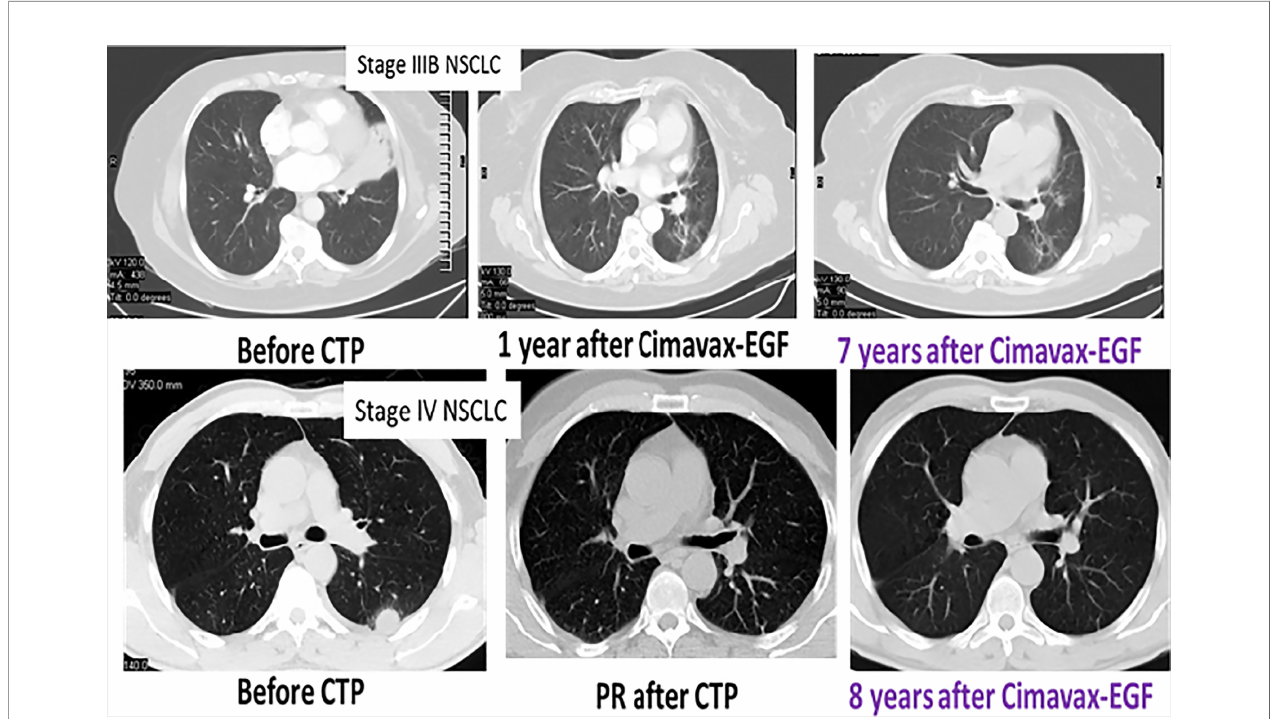
FIGURE 2 | Long-lasting disease control after CIMAvax-EGF. CT scan series of two representative